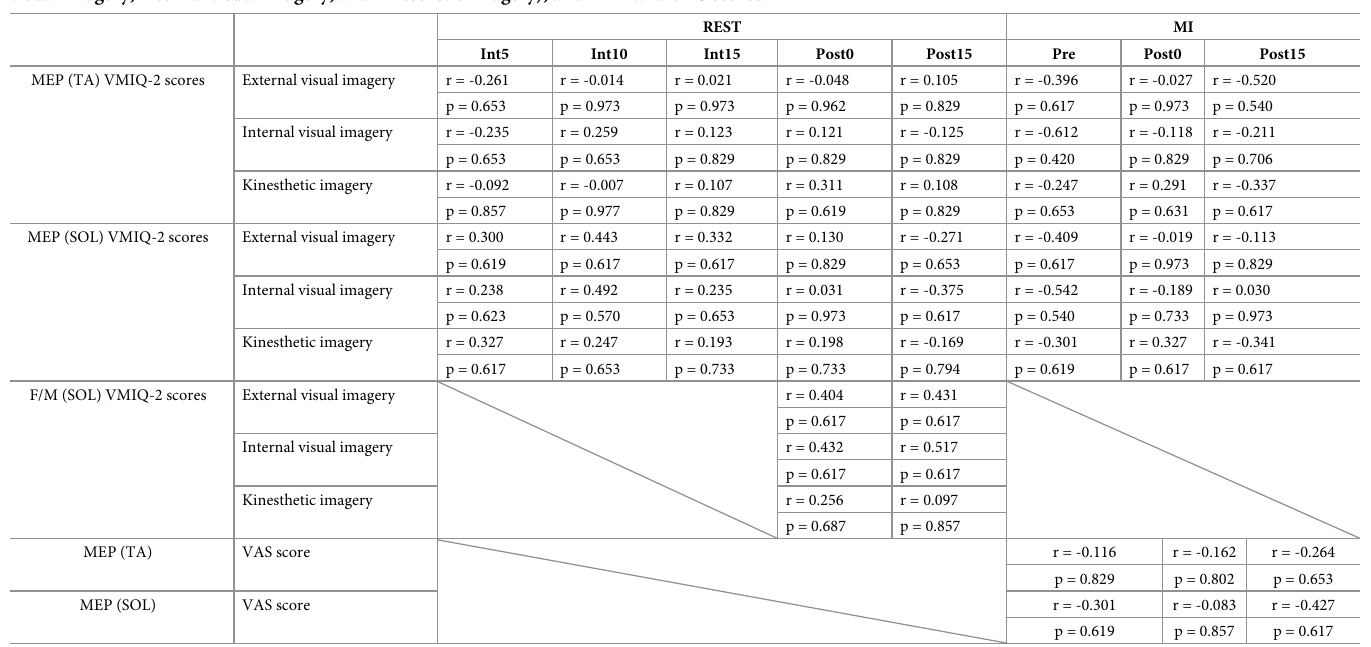
EMG, electromyography; and SOL, soleus.